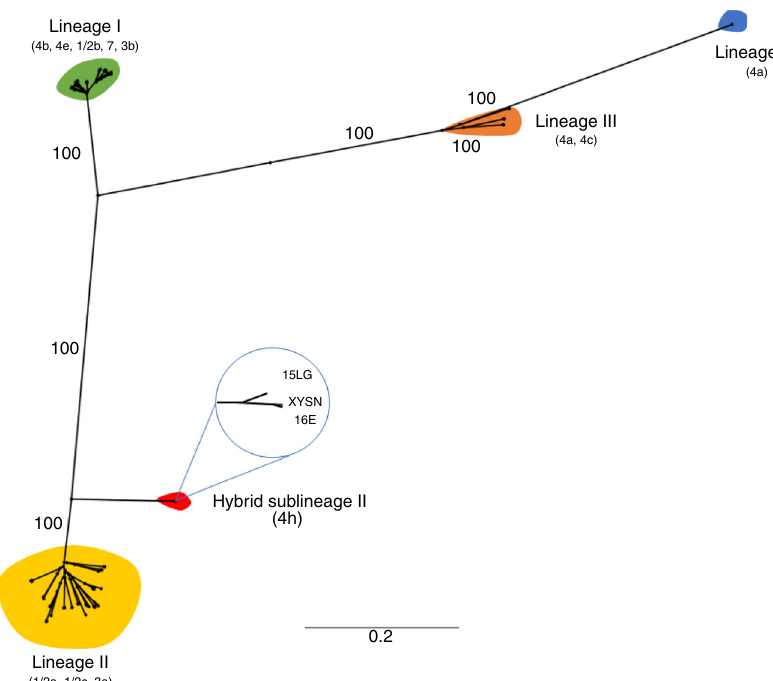
Fig. 2 Comparative phylogenomic analysis of L . monocytogenes . A phylogenomic tree based on the comparative analysis of the core genes derived from the closed genomes of 144 L . monocytogenes strains together with XYSN, 15LG, and 16E. The maximum likelihood phylogeny was inferred using RAxML (with 100 bootstrap values) based on the concatenated core gene sequence ( n = 1977 CDS, 1.69 Mb). L . monocytogenes XYSN, 15LG, and 16E formed a separate highly supported clade (100). Representative serotypes within the lineages are shown in